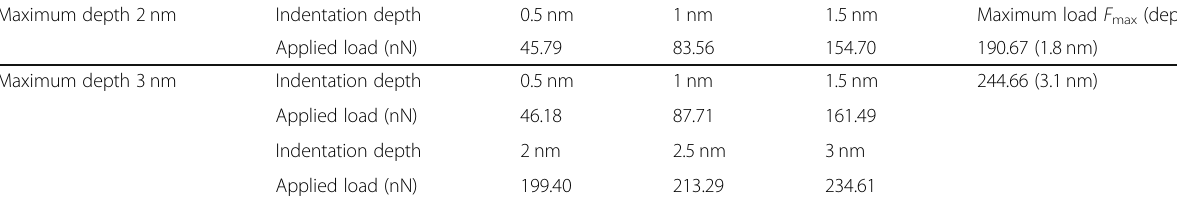
Table 3 Applied load on spacemen with different indentation depth